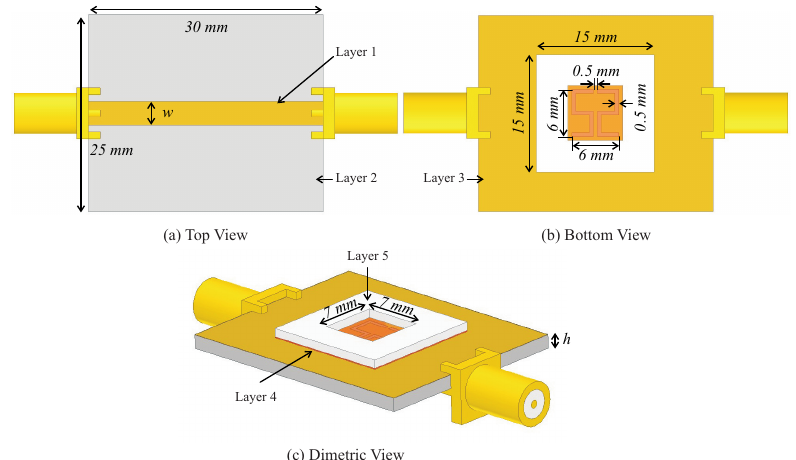
Figure 1. Three dimensional view of complementary metaresonator sensor. ( a ) Top view of the sensor where w = 3 mm, ( b ) Bottom view of the sensor, ( c ) Dimetric view of the sensor where h = 1.6 mm.